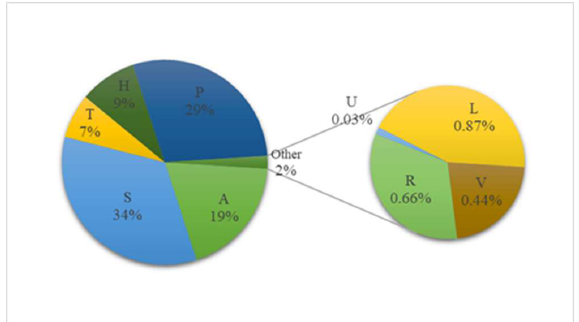
Figure 6. Geographical names in different categories in Britain.